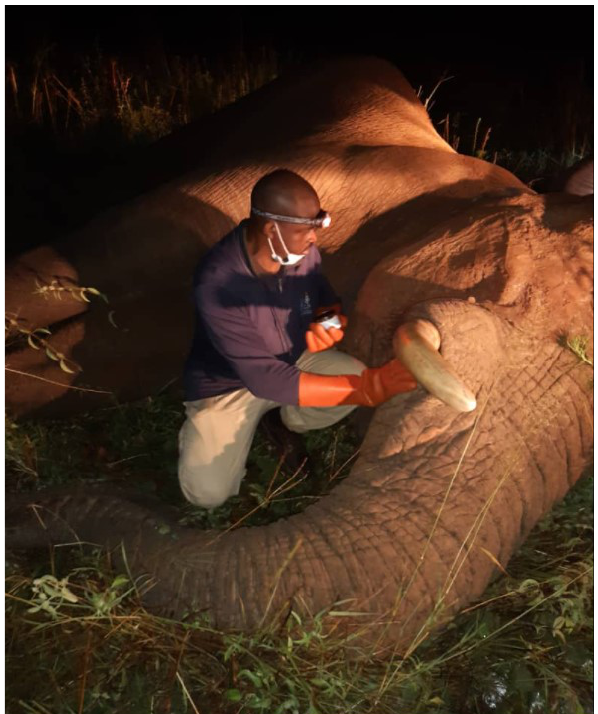
Figure 4 . Malvern Karidozo applies chilli mash to Bull 15 after the bull elephant was darted and a GPS collar was deployed.